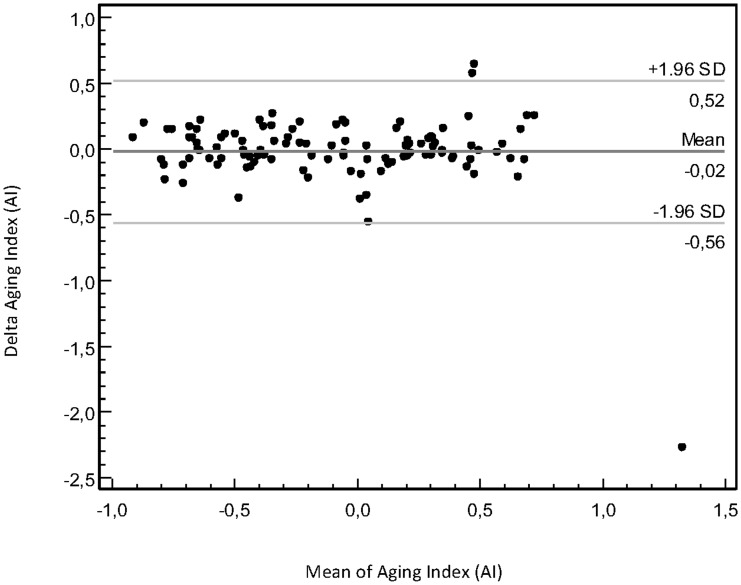
Repeatability of aging index.Bland-Altman plot of two consecutive measurements of aging index (AI) by the Meridian DPA apparatus, depicting the relationship of difference of measurements (Delta AI) and mean value of measurements.